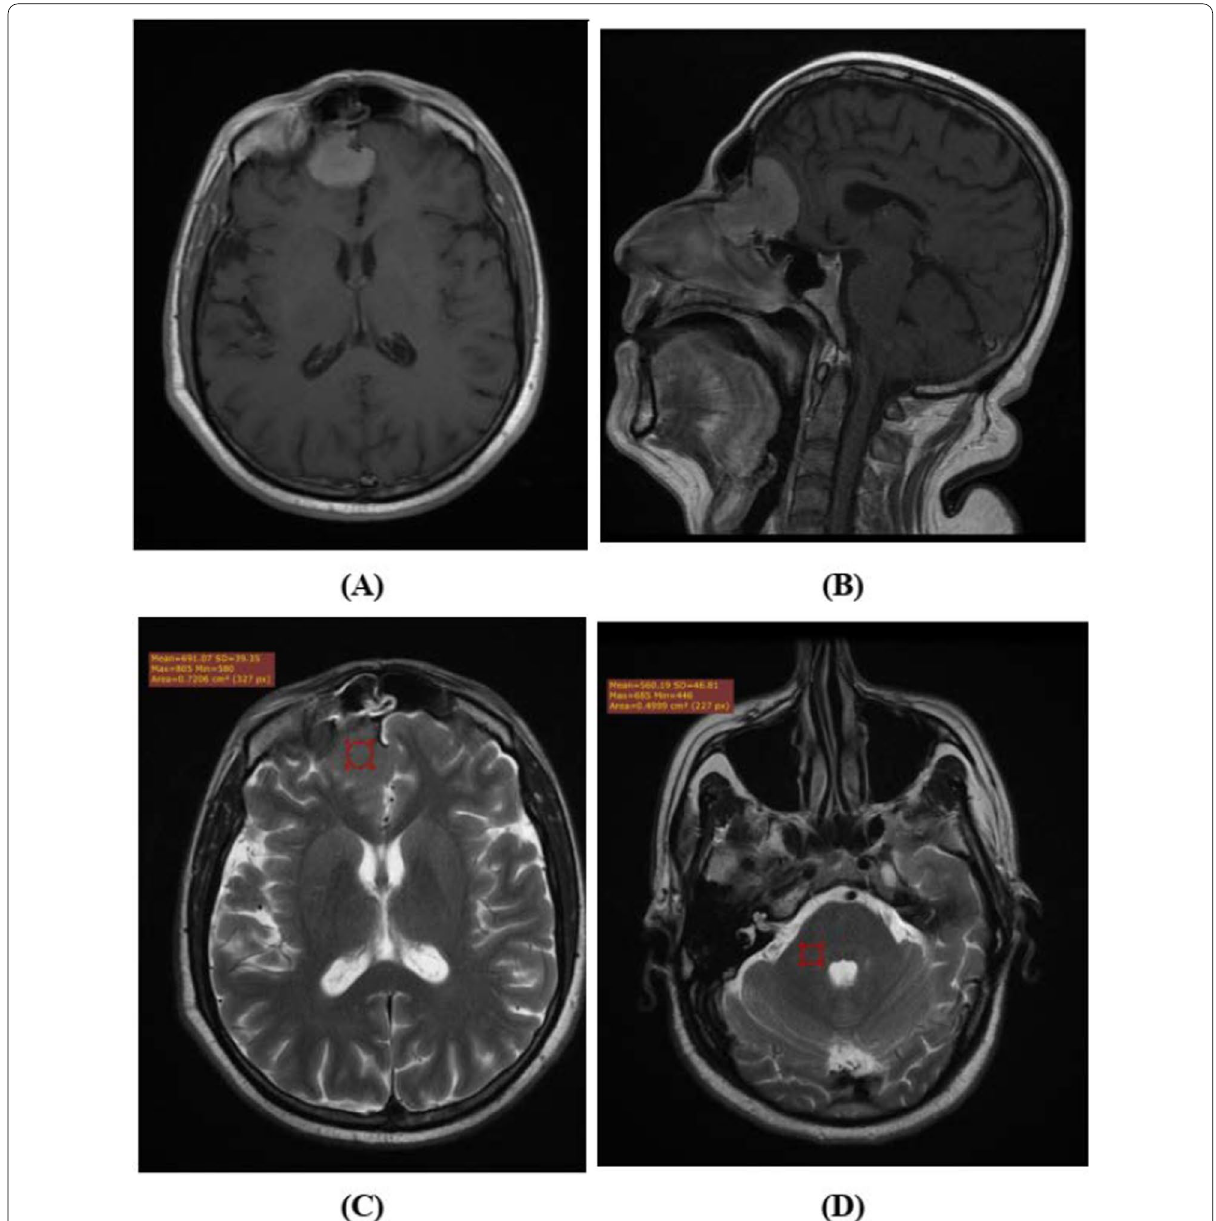
Fig. 3 MRI of intermediate consistency olfactory groove meningioma. A , B Axial and sagittal T1 post contrast showing intensely enhancing olfactory groove meningioma. C , D Axial T2-weighted MR images at the same level and at the level of middle cerebellar peduncles with ROI on the lesion and right middle cerebellar peduncle showing TCTI ratio of 1.4, proved surgically to have intermediate